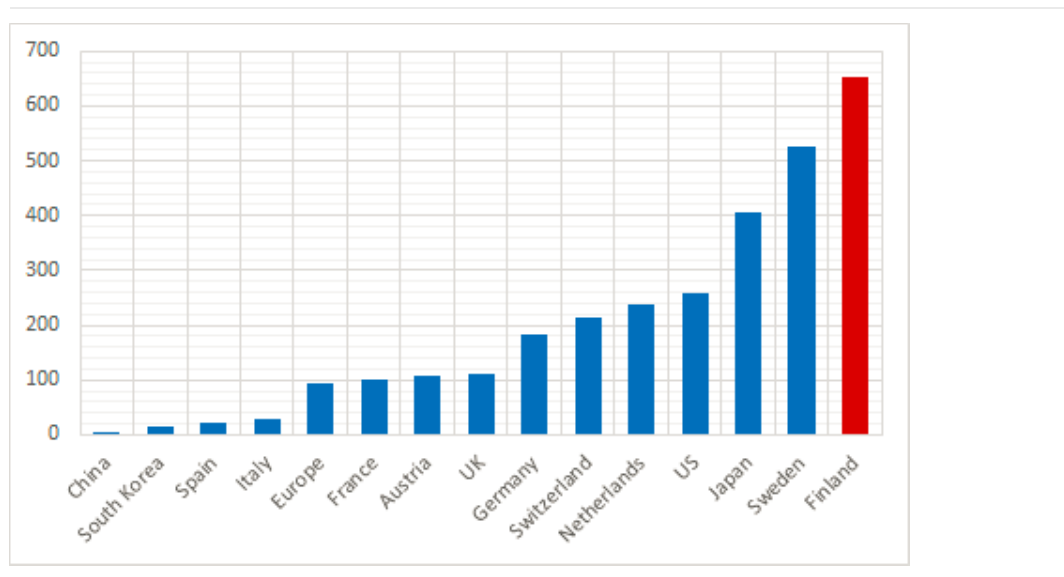
FIGURE 4: Patent filings (4IR tech) per million inhabitants 2000-2018 (EPO,